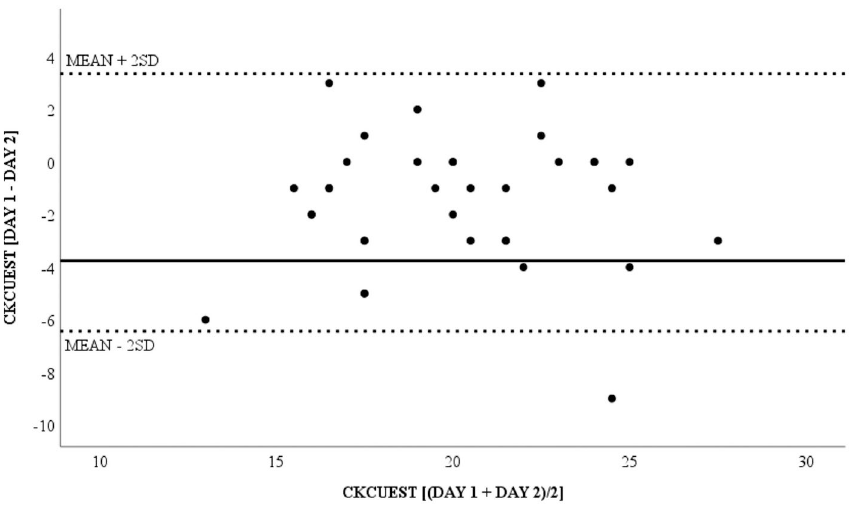
Figure 1 - Bland-Altman Plot for the number of touches in the Closed Kinetic Chain Upper Extremity Stability Test. The straight line represents bias and dotted lines 95% limits of